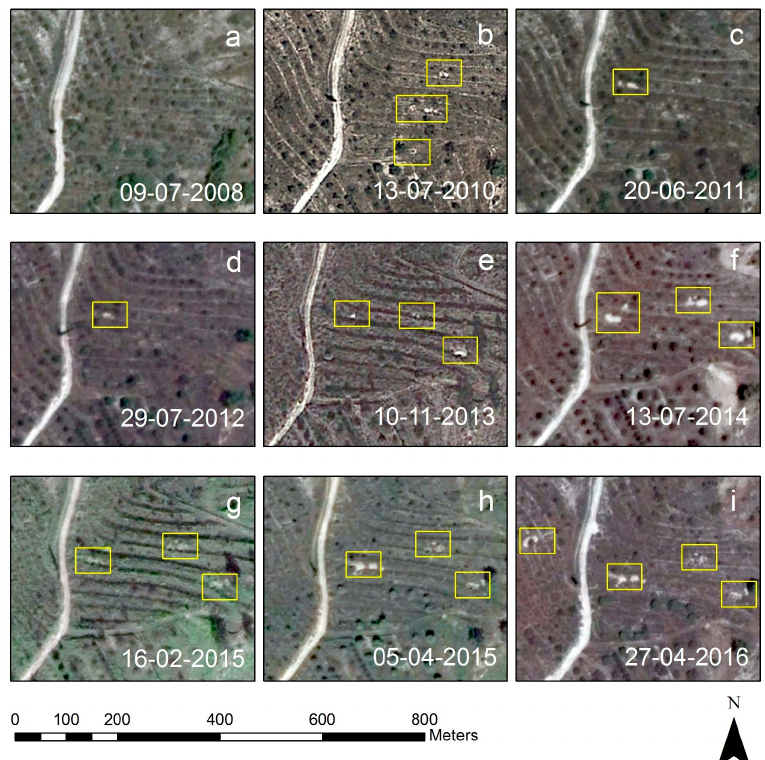
Figure 4. RGB Google Earth© images over the area of interest between the years 2008 and 2016 as follows ( a ) 9 July 2008, ( b ) 13 July 2010, ( c ) 20 June 2011, ( d ) 29 July 2012, ( e ) 10 November 2013, ( f ) 13 July 2014, ( g ) 16 February 2015, ( h ) 5 April 2015, and ( i ) 27 of April 2016. Looted tombs are indicated by the yellow squares.